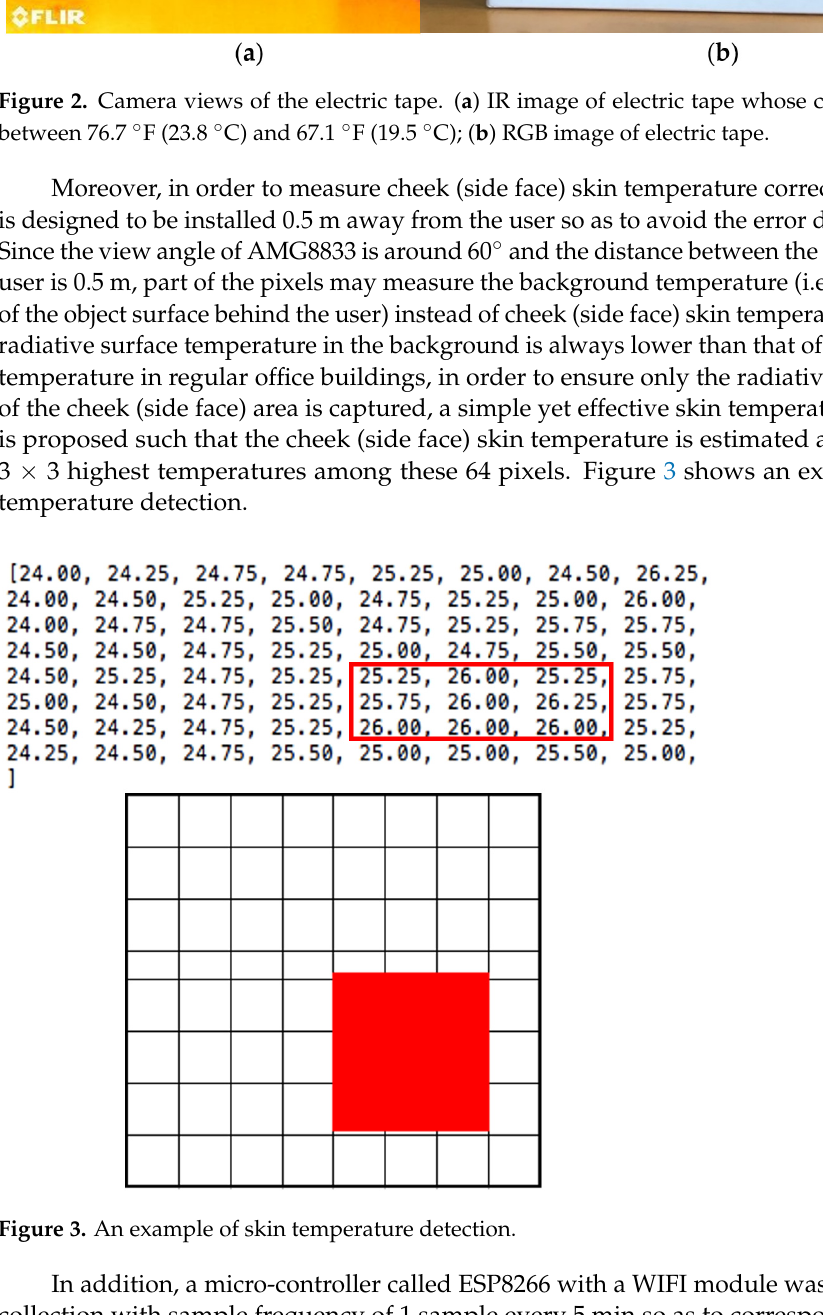
Figure 4. The non-intrusive sensor board. Besides the sensing system, the personalized cooling system also includes an 8 ′ desktop mini-fan (since the air velocity > 0.2 m/s also has cooling effects [29], the supply direction is adjusted so that the air velocity towards each occupant is controlled within 0.1 m/s without draft risk). Compared to a conventional air-conditioning system, the TAC system with a fan has several advantages. Firstly, fans offer a straight-forward, economic, and independently operable technique to increase movement of air so as to ultimately improve thermal comfort in a room [29]. Moreover, when operated with an AC system, the downwash propelled by foil (rotating) drives the warm air downwards to blend with the cold air, countering the impacts of buoyancy [30].